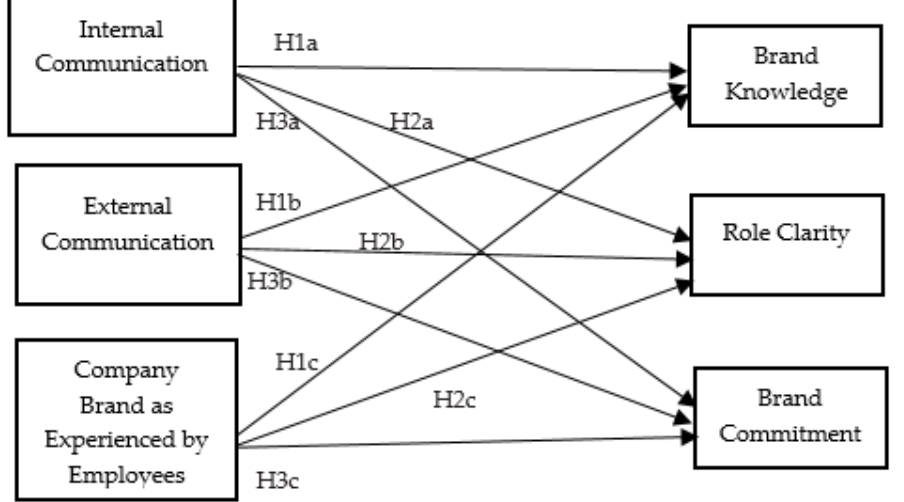
Figure 1. Proposed conceptual model of the study.